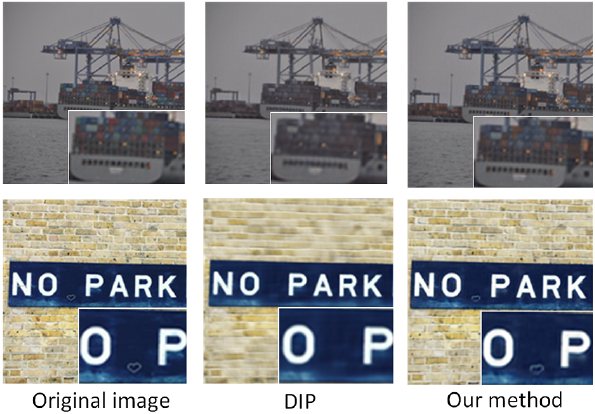
Figure 7. Comparison of images generated by our method with a single DIP network. With a similar number of iterations, our method can reconstruct images with more